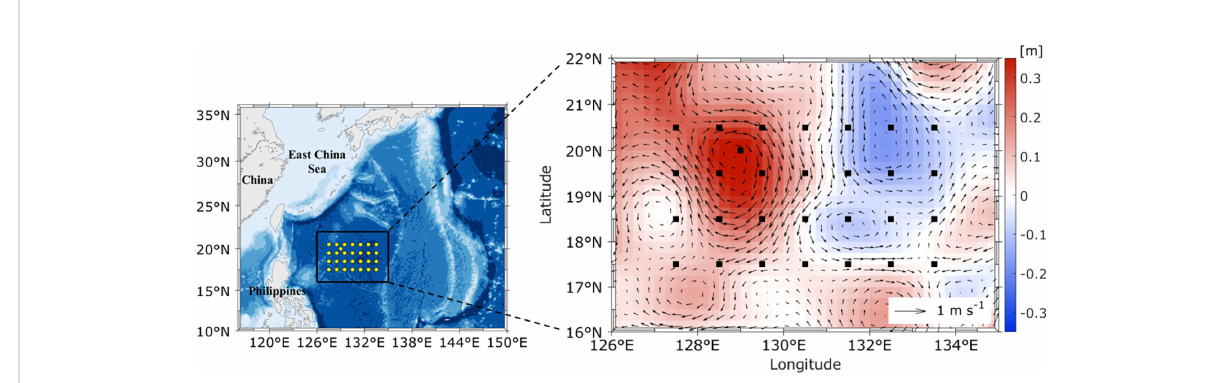
FIGURE 1 Map of the study area and locations of sampling stations overlaid on mean sea surface height anomaly and geostrophic velocity in the northern Philippine Sea from September 14th to 23rd, 2017. Red color indicates an anticyclonic eddy, and blue color indicates a cyclonic